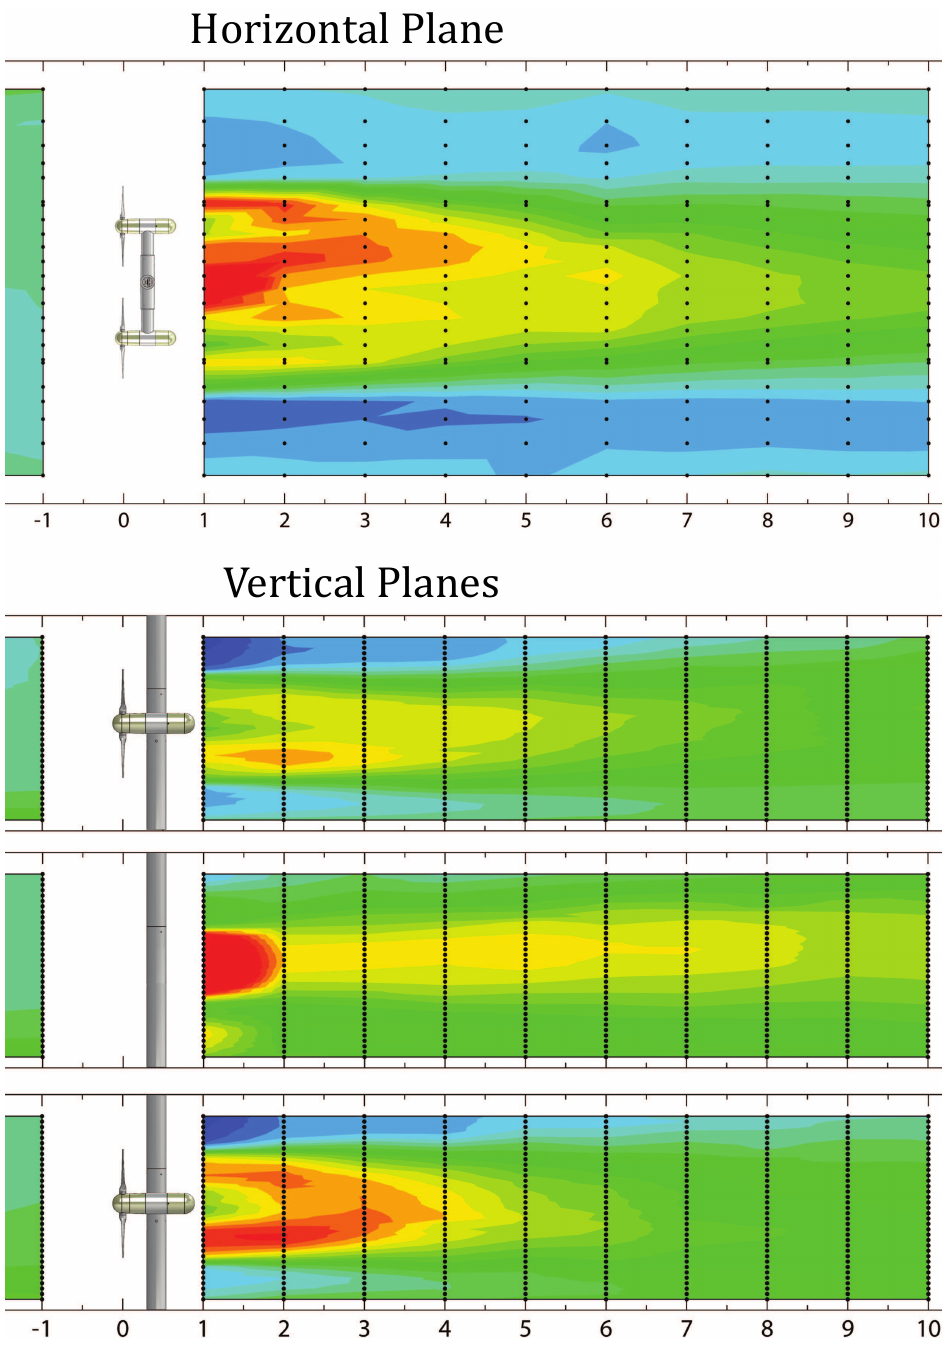
Figure 11. Velocity deficit horizontal ( xy ) and vertical ( xz ) plane contours upstream and downstream of RM1 in the SAFL Main Channel. Horizontal plane y -axis, y / d T , shows full channel width ( b = 2.75 m). Vertical planes y -axis, z / d T , shows full water depth during the experiment ( h = 1.0 m). Horizontal and vertical dotted black lines indicate actual ADV measurement locations. ADV vertical point spacing ∆ z = 0.025 m ( z / d = 0.05). Horizontal spacing varied. Measurements collected at λ ≈ 5.1 ( ω = 3.4 rps). T Flow is left to